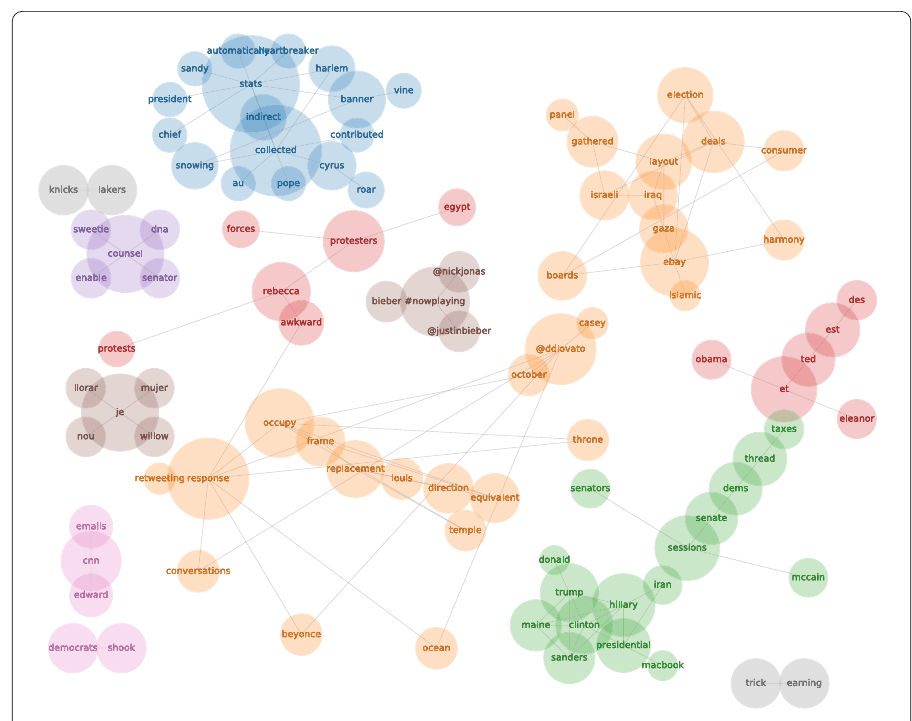
Figure 15 Topic network inferred from weighted shock indicator functions. At each point in time, words are ranked according to the value of their weighted shock indicator function and the top k words are taken and (cid:6) (cid:5) k additional edges in the network; if the edge between words i and linked pairwise for an upper bound of 2